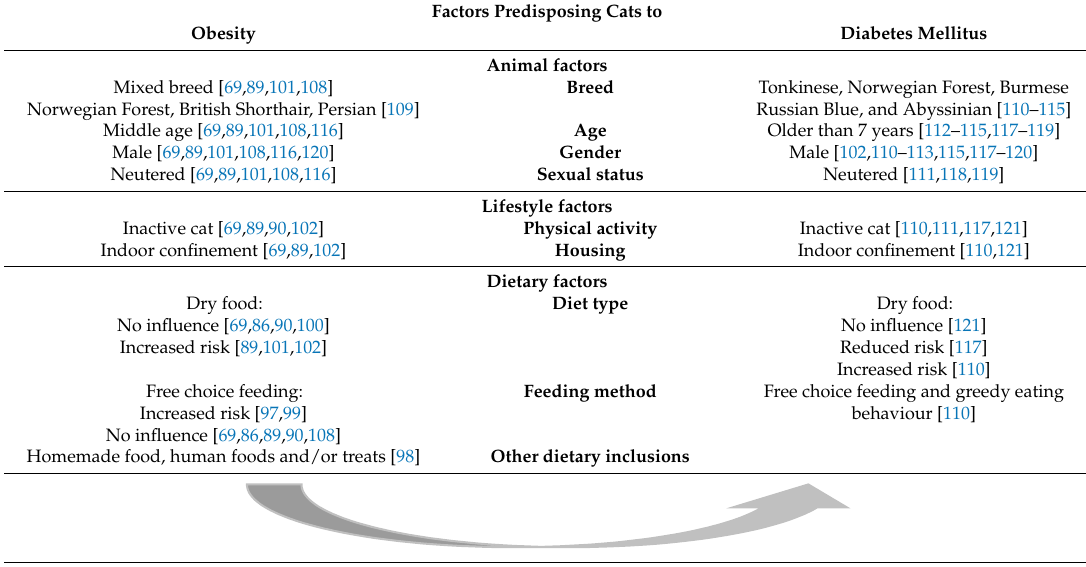
Table 2. Animal, lifestyle and dietary factors increasing the risk for feline obesity and diabetes mellitus. Factors Predisposing Cats to Obesity Diabetes Mellitus Animal factors Breed Tonkinese, Norwegian Forest, Burmese Mixed breed [69,89,101,108] Norwegian Forest, British Shorthair, Persian [109] Russian Blue, and Abyssinian [110–115]